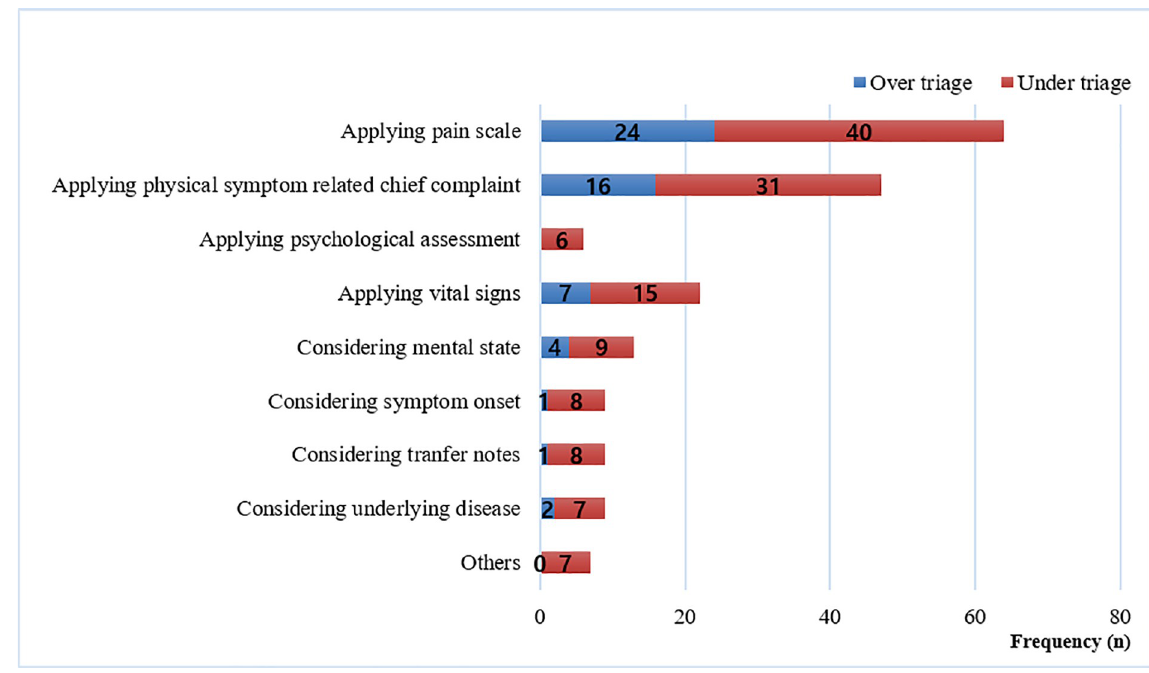
Fig 3. Causes of triage error (n =